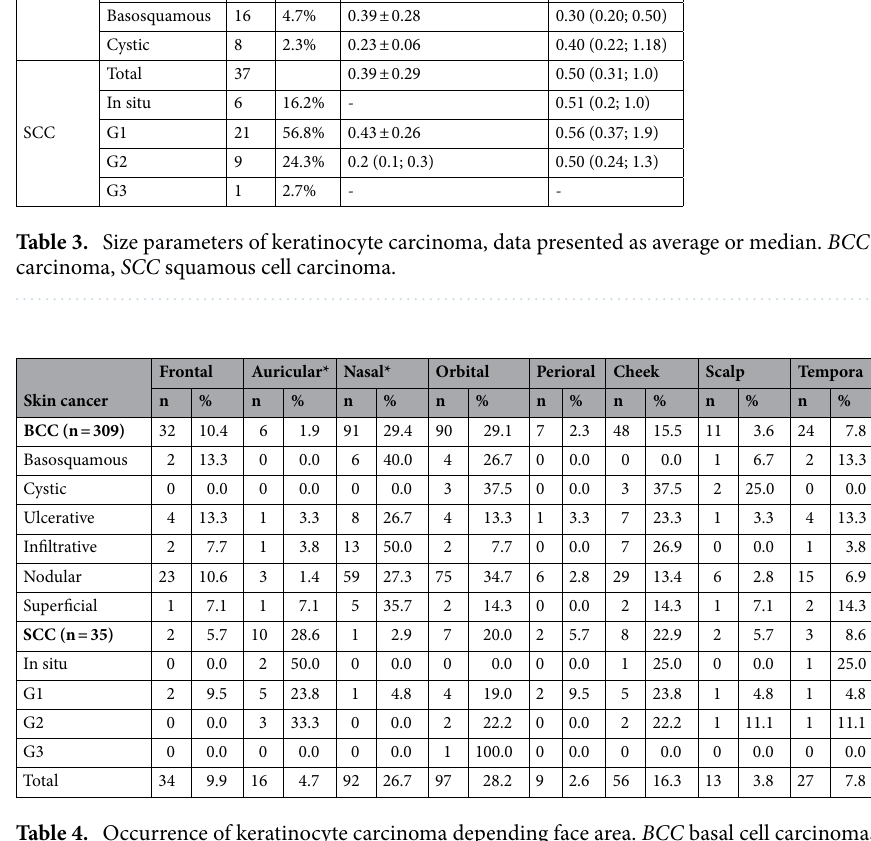
Table 4. Occurrence of keratinocyte carcinoma depending face area. BCC basal cell carcinoma, SCC squamous cell carcinoma. *SCC significantly more frequent affect auricular area than BCC ( P < 0.001). In the other hand, BCC were more associated with nasal area than SCC ( P = 0.001).